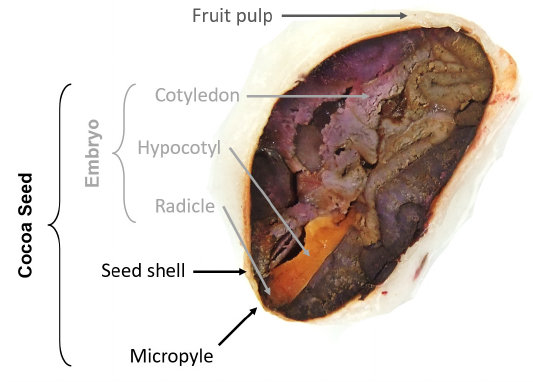
Fig. 2: Cocoa seed